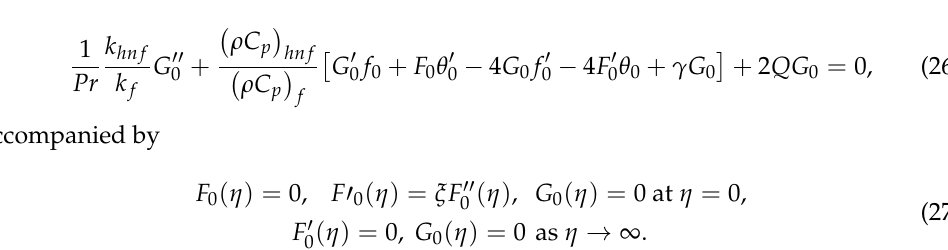
√ √ 2 Re 1/2 x C f and 2 Re − 1/2 x Nu x for Al 2 O 3 /water ( φ 2 = 0) with